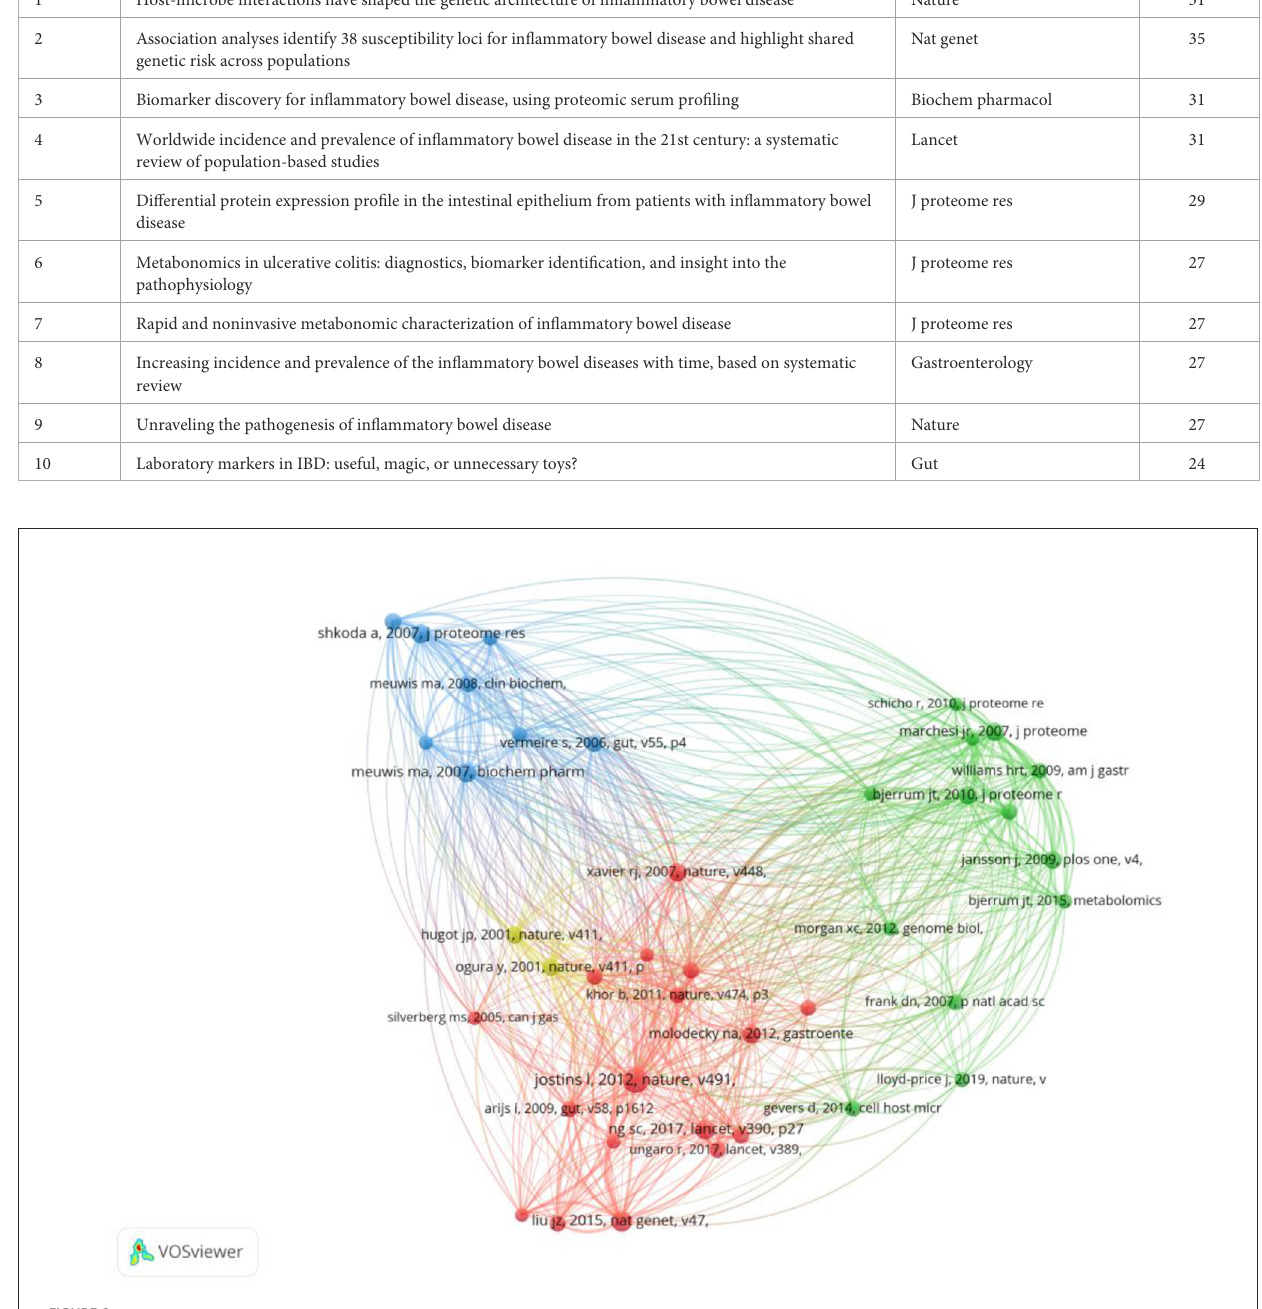
bowel diseases (34, 35). Thus, the achievements of the top 10 leading co-authors laid the foundation for the research of omics in